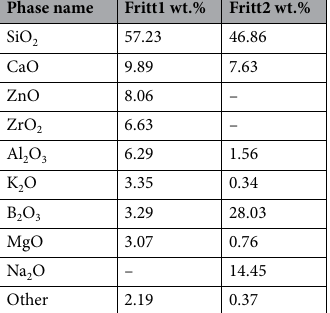
Table 2. Composition of Fritt1 and Fritt2 used in the experiments (on a dry basis).